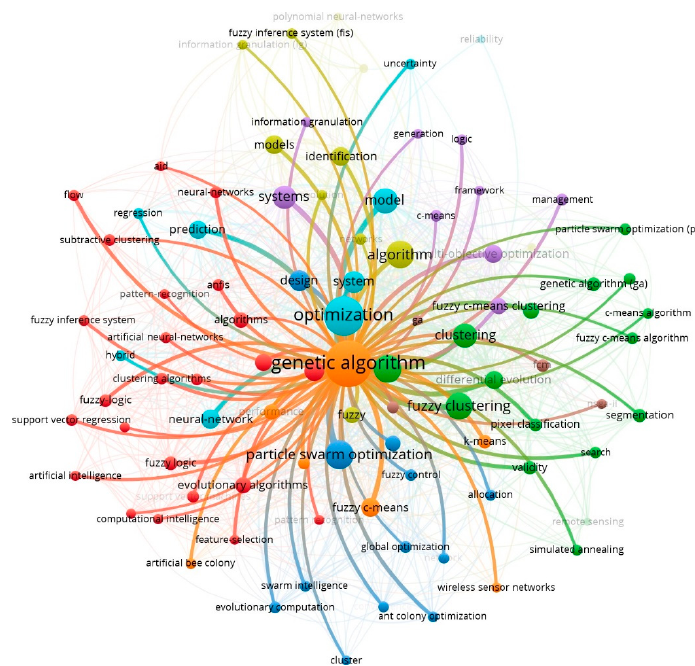
Figure 6. Representation of the selection of the keyword “genetic algorithm”.